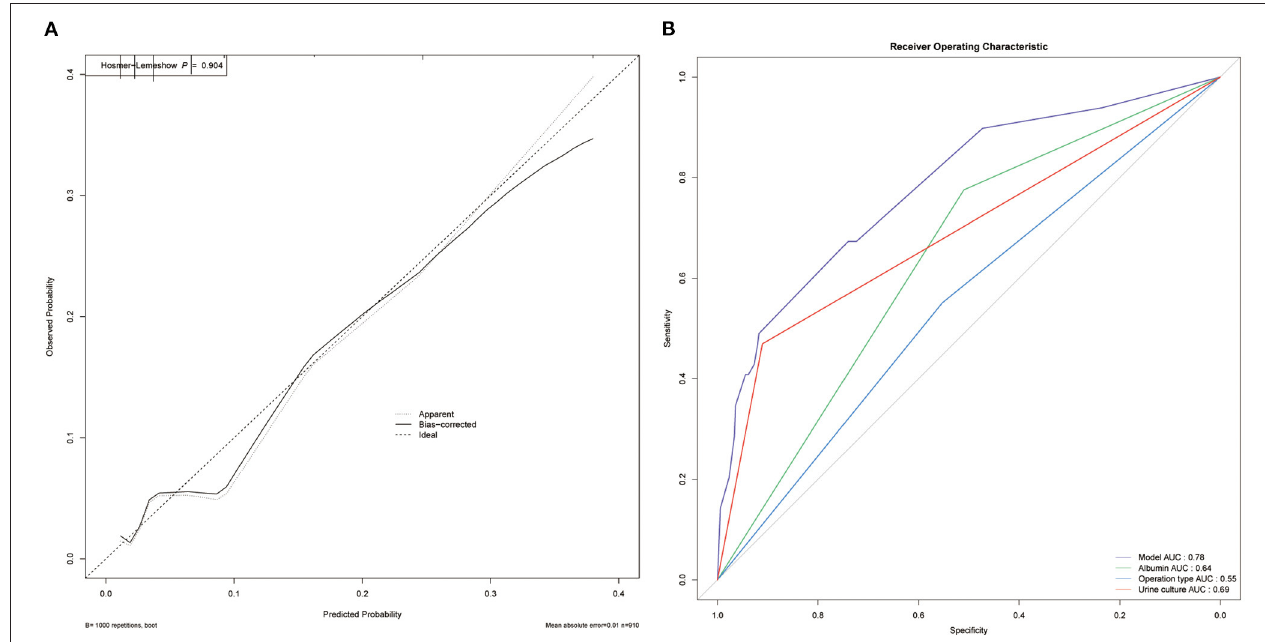
FIGURE 4 | Evaluation of the predictive performance. (A) Calibration curve. The The HL test with insignificant p -value indicates good fitting of the model. (B) Receiver operating characteristic (ROC) curve. The area under curve (AUC) for the model is 0.78, which showed a favorable ability of